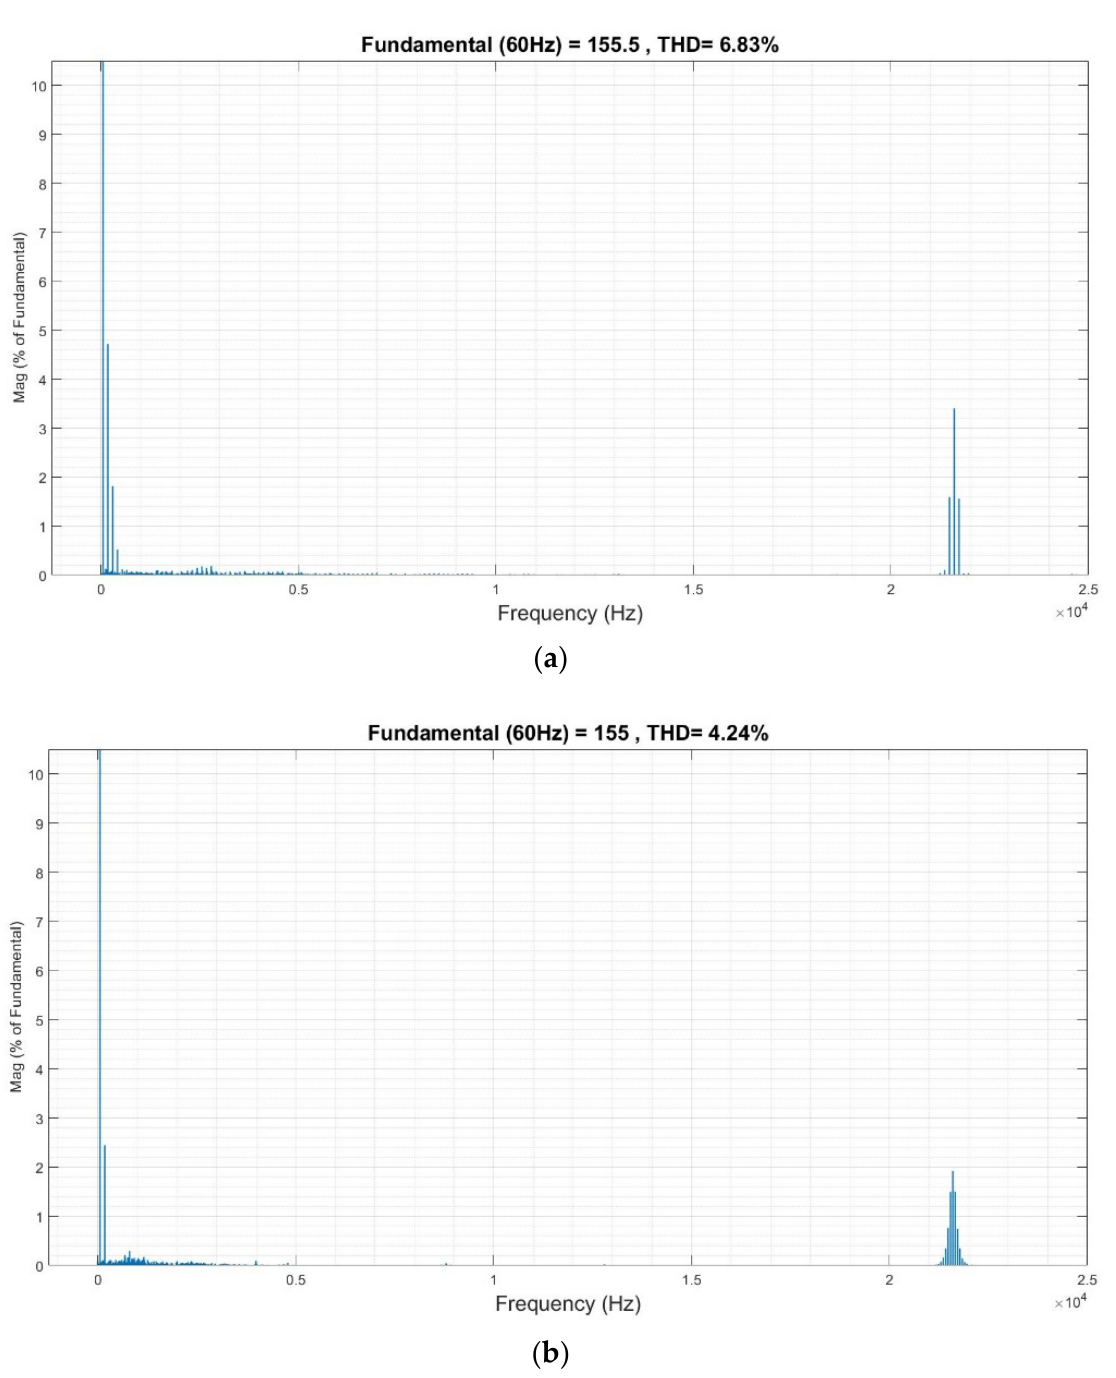
Figure 23. THD analysis of the simulation (1 kW) when using ( a ) the traditional SPWM control and ( b ) modified SPWM control.